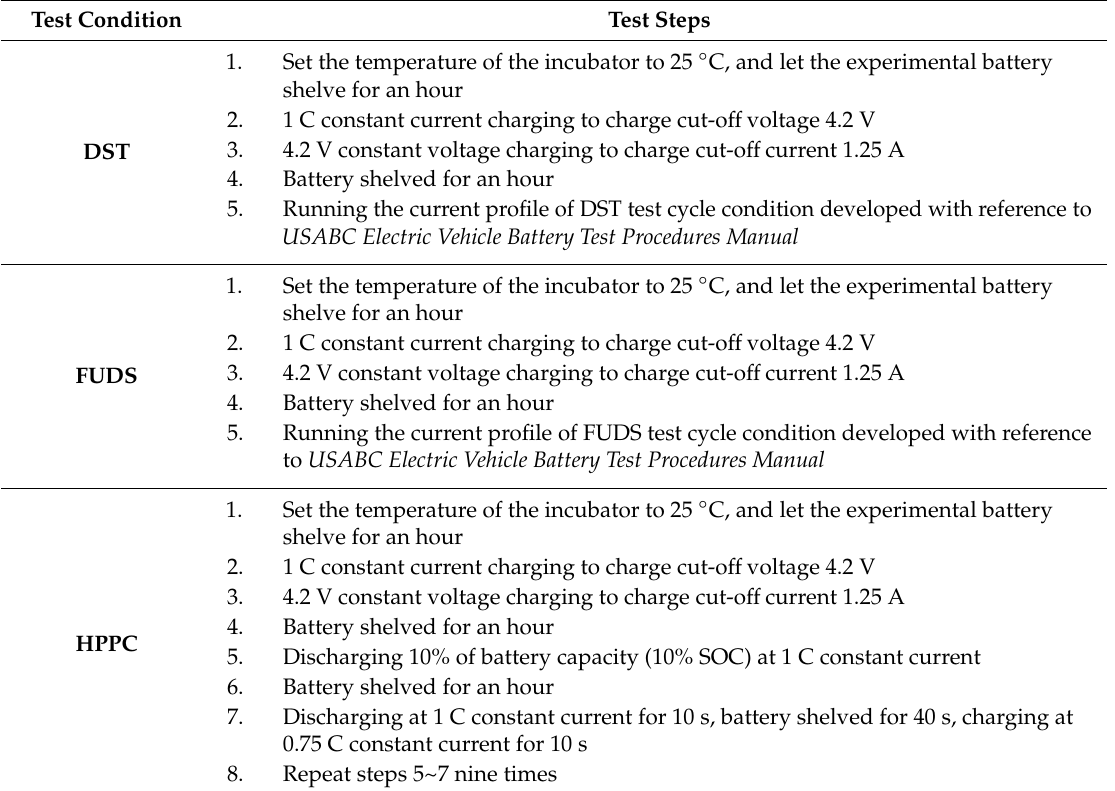
Table 10. The specific experimental steps of the dynamic stress test (DST), federal urban driving schedule (FUDS), and hybrid pulse power characteristic (HPPC) test